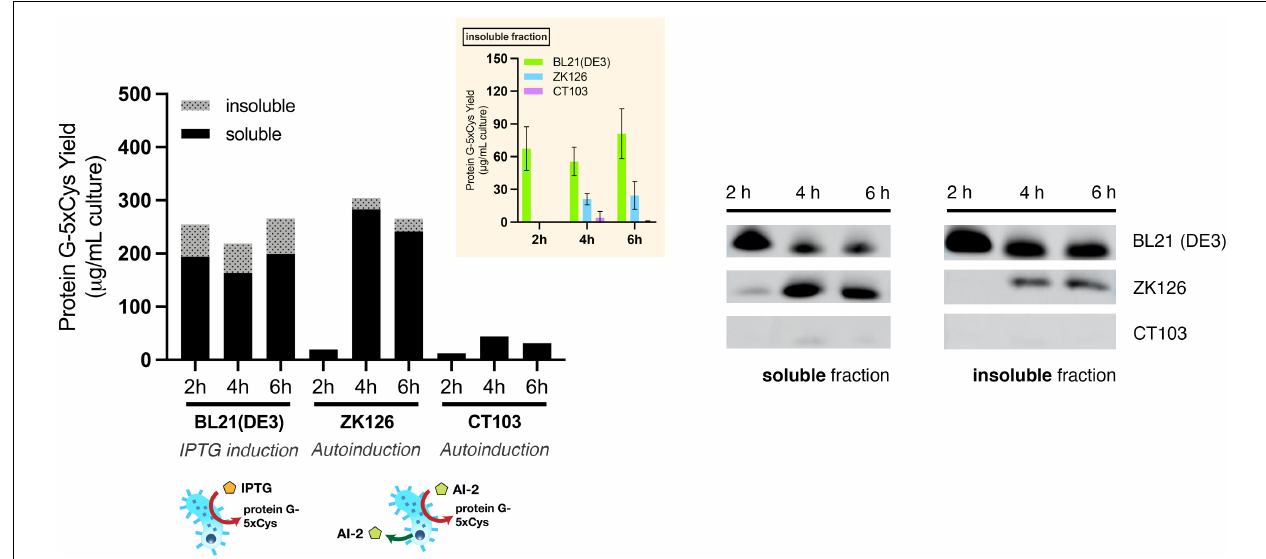
FIGURE 5 | Protein G-5xCys production with conventional IPTG induction and QS-mediated autoinduction. Total yield of protein G-5xCys ( µ g) per mL of BL21 (DE3), ZK126 and CT103 culture, analyzed by Western blotting. Black: soluble fraction; dotted: insoluble fraction. Plotted values represent the average of biological replicates ( n = 3). Yields of protein G-5xCys in the insoluble fractions ( µ g/per mL culture) are also shown in the inset plot. Error bar represents the standard deviation between replicates.